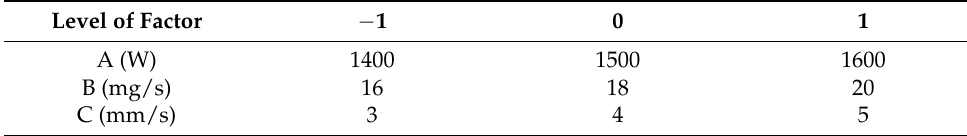
Table 3. Experimental factors and levels.